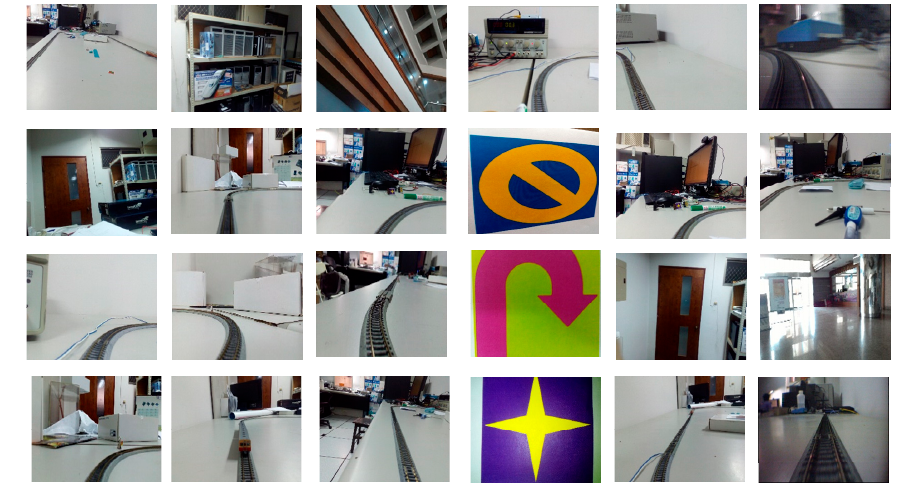
Figure 4. Some negative samples of acceleration sign.